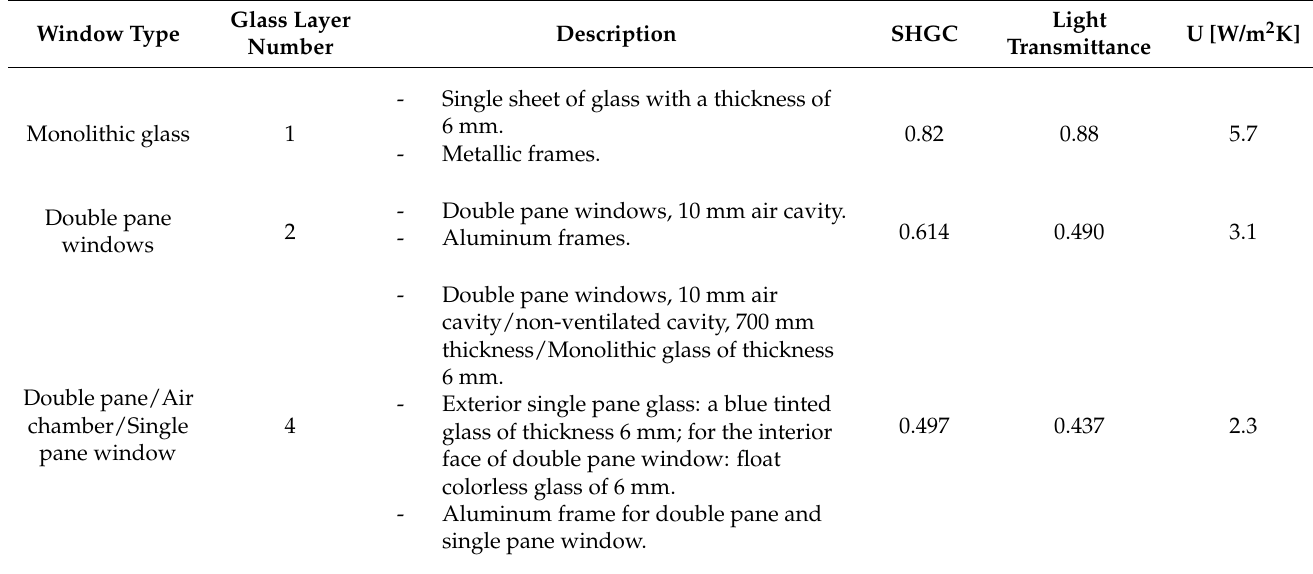
Table 2. Construction specification and thermal parameters of the windows.